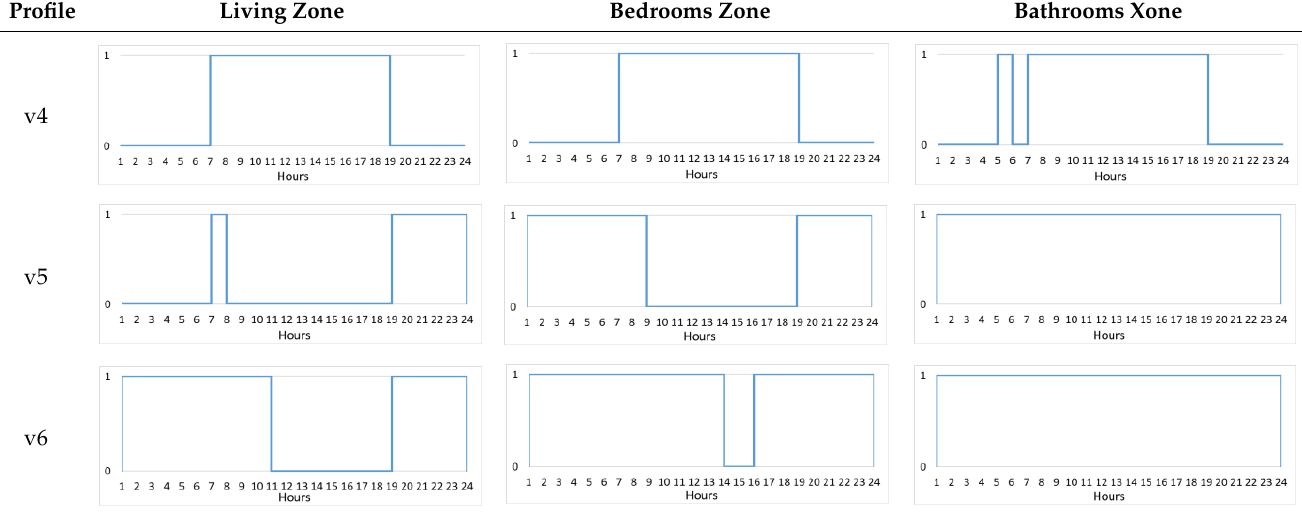
Table 6. Energy consumption [kWh/year] for heating and cooling with setpoint temperatures of 20 °C (heating) and 26 °C (cooling). Season Profiles